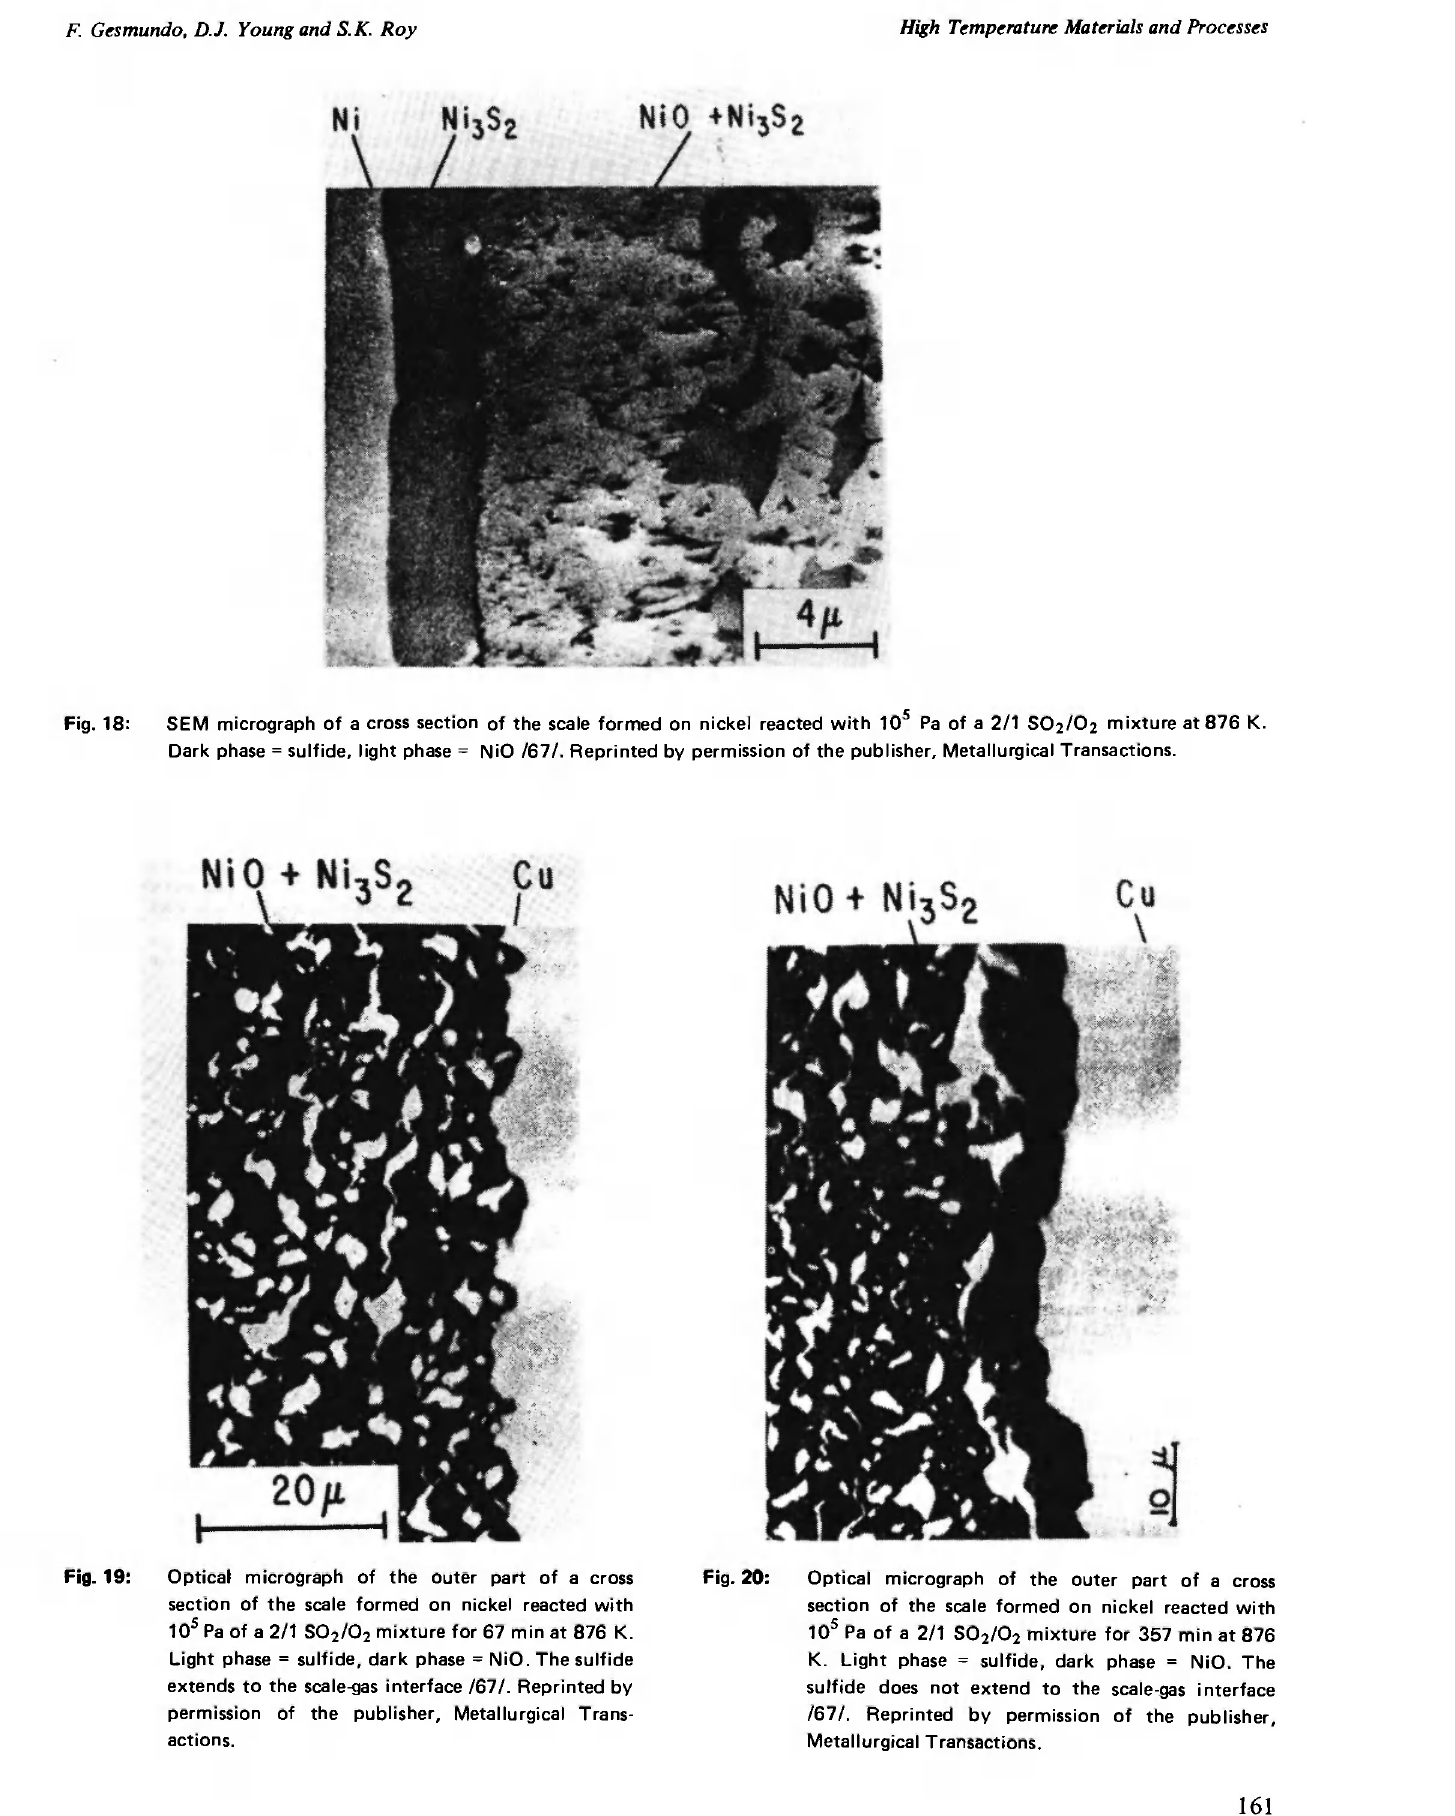
Fig. 20: Optical micrograph of the outer part of a cross section of the scale formed on nickel reacted with 10 5 Pa of a 2/1 S0 2 /0 2 mixture for 357 min at 876 K. Light phase = sulfide, dark phase = NiO. The sulfide does not extend to the scale-gas interface /67/. Reprinted by permission of the publisher. Metallurgical